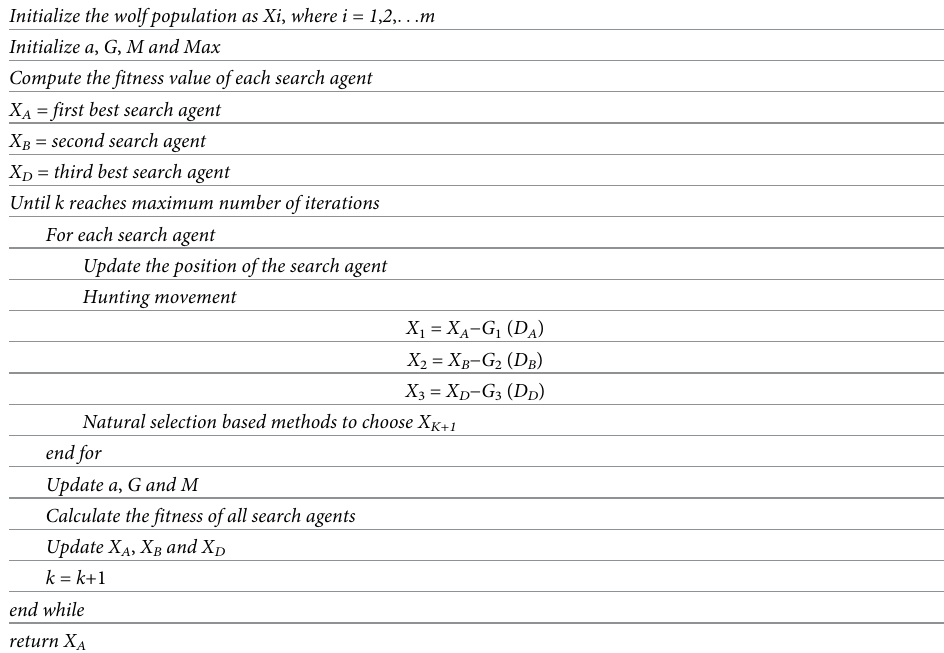
Table 1. Algorithm for the proposed work. Initialize the wolf population as Xi , where i = 1 , 2 , ... m Initialize a , G , M and Max Compute the fitness value of each search